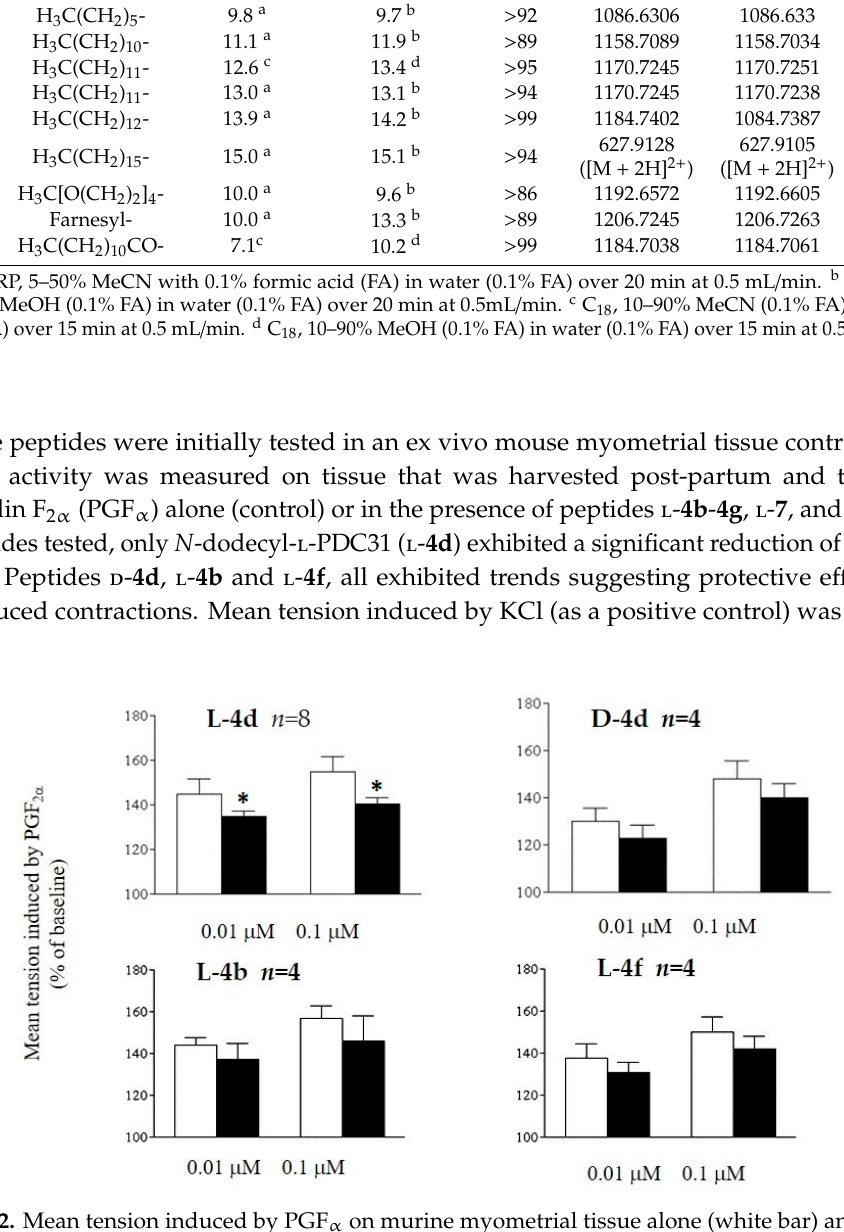
Peptide Table 1. Retention time, purity, exact mass and overall yield of peptides 4b–4g , 7 and 8 .